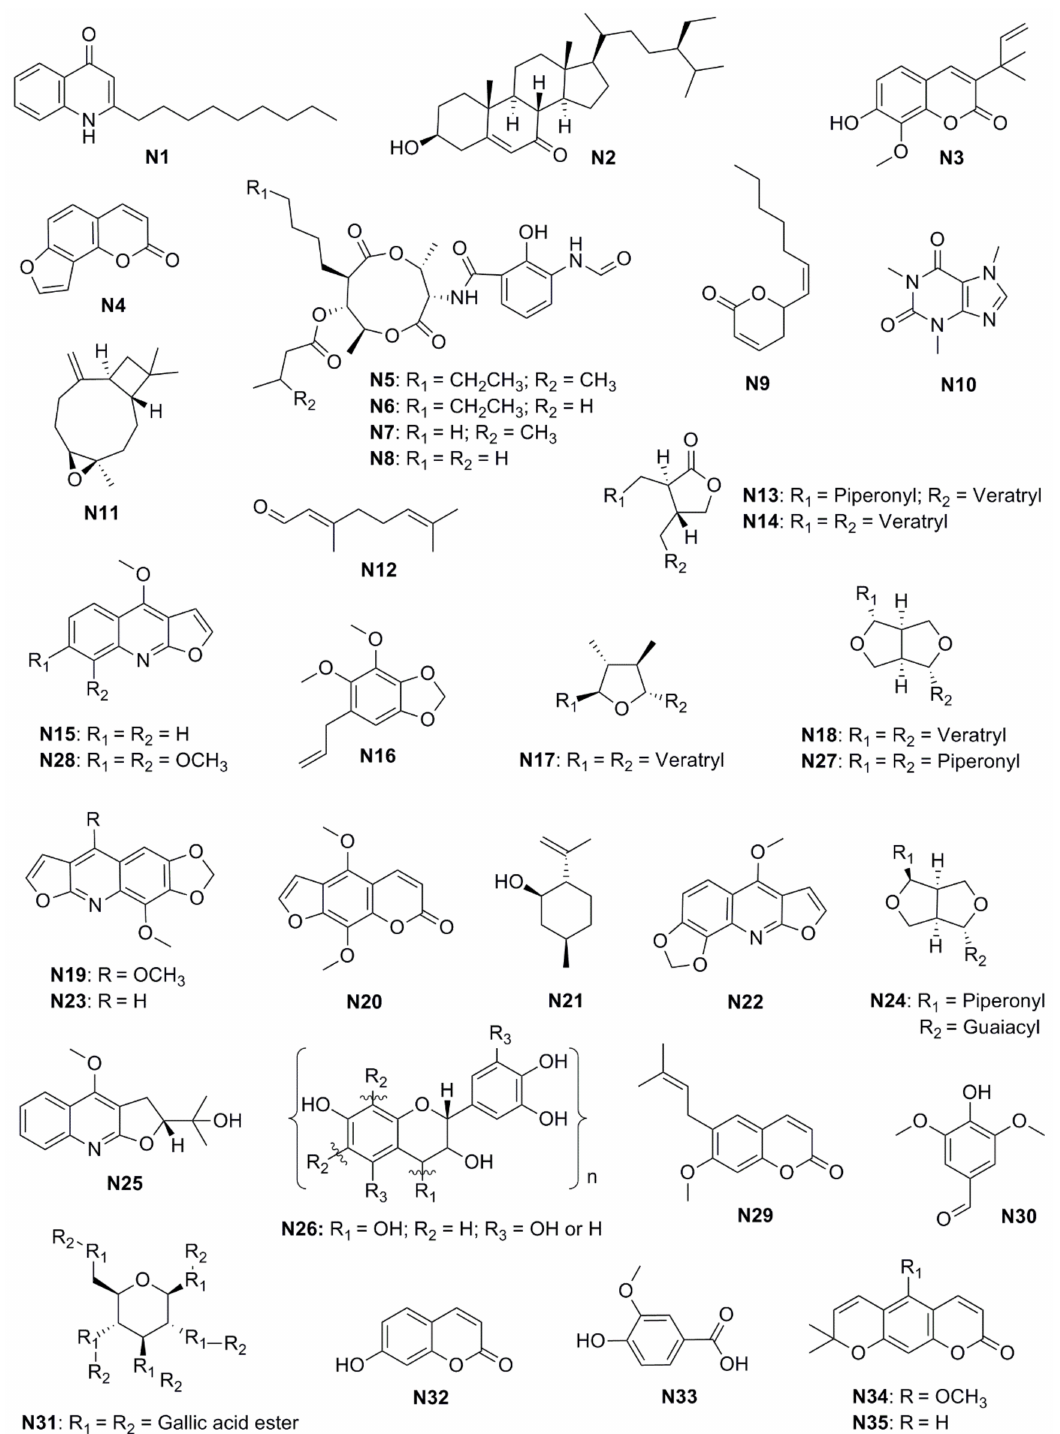
Figure 2. Chemical structure of natural compounds with potential antifungal effects against Leucoa- garicus gongylophorus